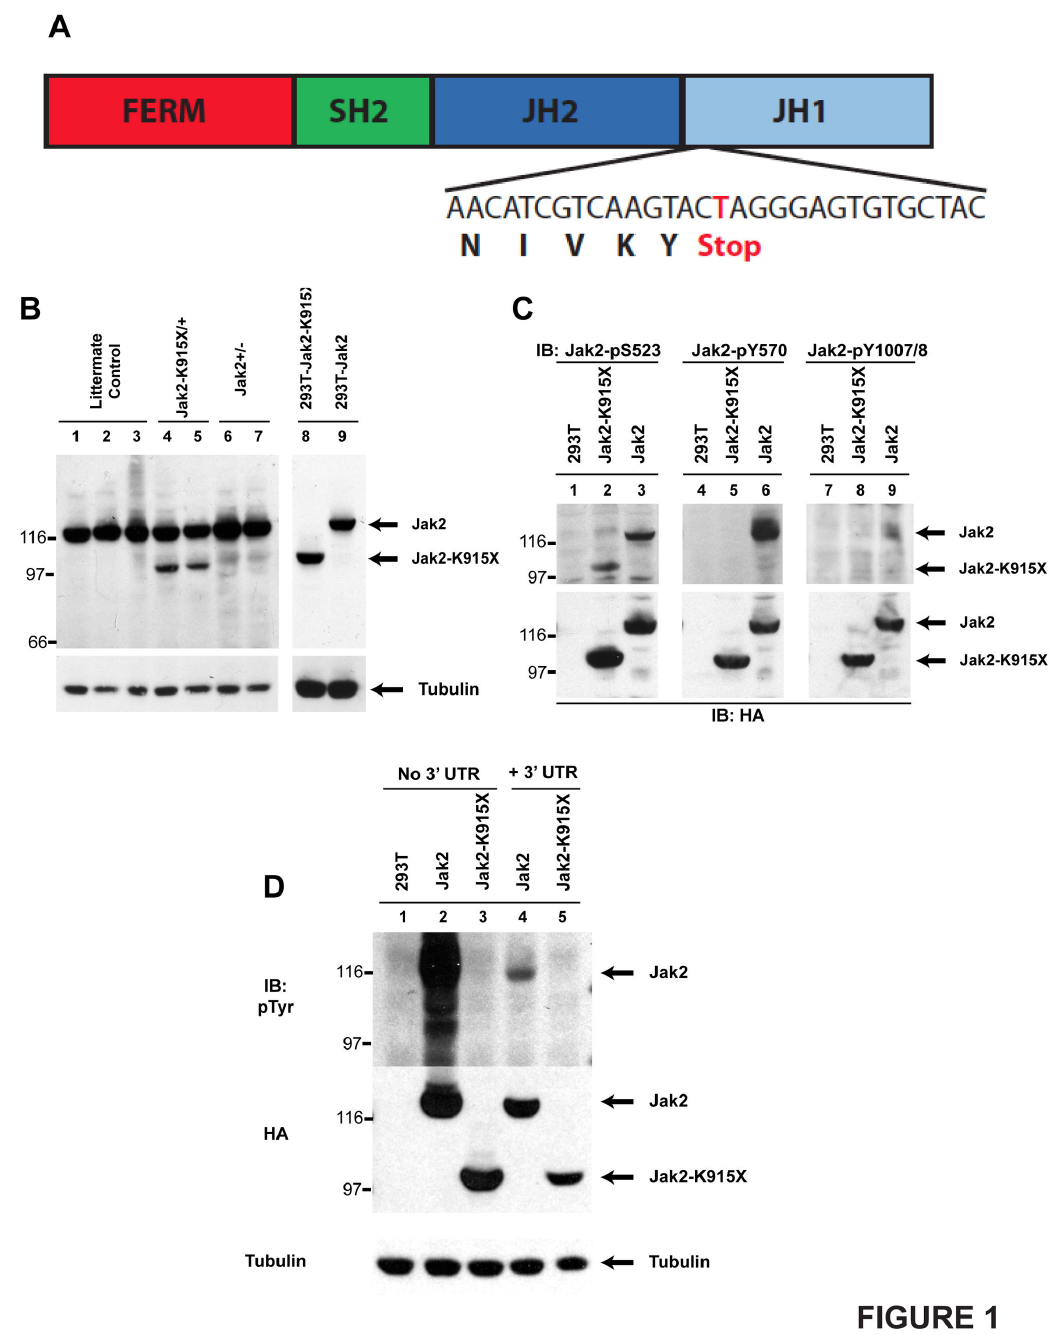
Figure 1. Strain 7254 is defined by a K915X mutation and generates a non-functional truncated Jak2 protein. (A) The Jak2 domain structure is indicated. The DNA sequence from 7254 splenocytes and corresponding protein sequence are also shown. (B) Splenocytes were harvested from phenylhydrazine primed Jak2 K915X and Jak2 +/- mice and their wild type littermates. HA-tagged Jak2 and Jak2 K915X were also expressed in 293T cells. A Western blot was performed with a peptide-specific JAK2 antibody. (C) 293T cells were transfected with cDNAs encoding HA-Jak2 or HA-Jak2 K915X. Western blotting was performed with phosphorylation- specific antibodies that recognize pSer-523, pTyr-570 and pTyr-1007/1008 in Jak2. The membranes were stripped and reprobed with an anti-HA antibody. (D) HA-tagged versions of Jak2 and Jak2 K915X with or without the JAK2 3’ UTR were expressed in 293T cells. Western blots were performed with 4G10 anti-phosphotyrosine and HA antibodies. Immunoblotting with anti β-tubulin was performed to demonstrate equal loading. doi: 10.1371/journal.pone.0075472.g001 PLOS ONE |